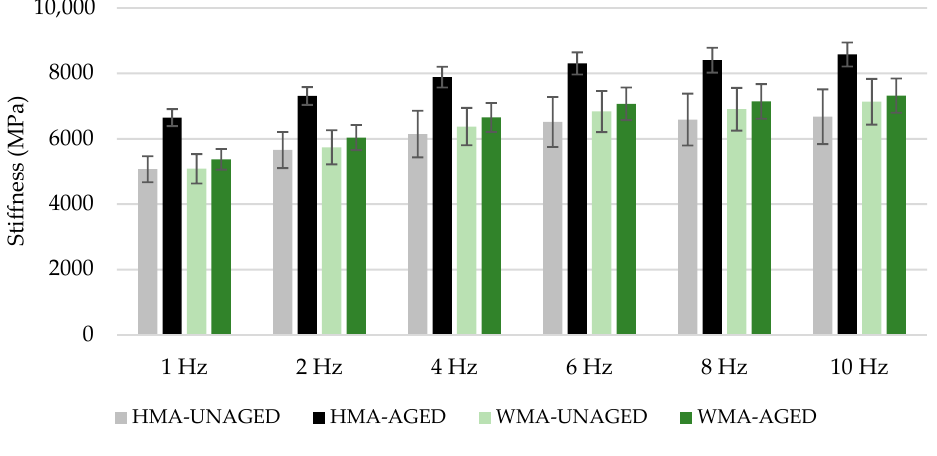
Figure 9. Results of stiffness.